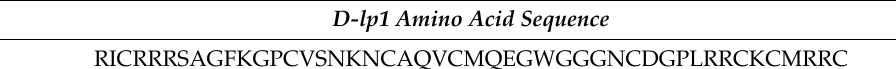
Table 2. D-lp1 amino acid